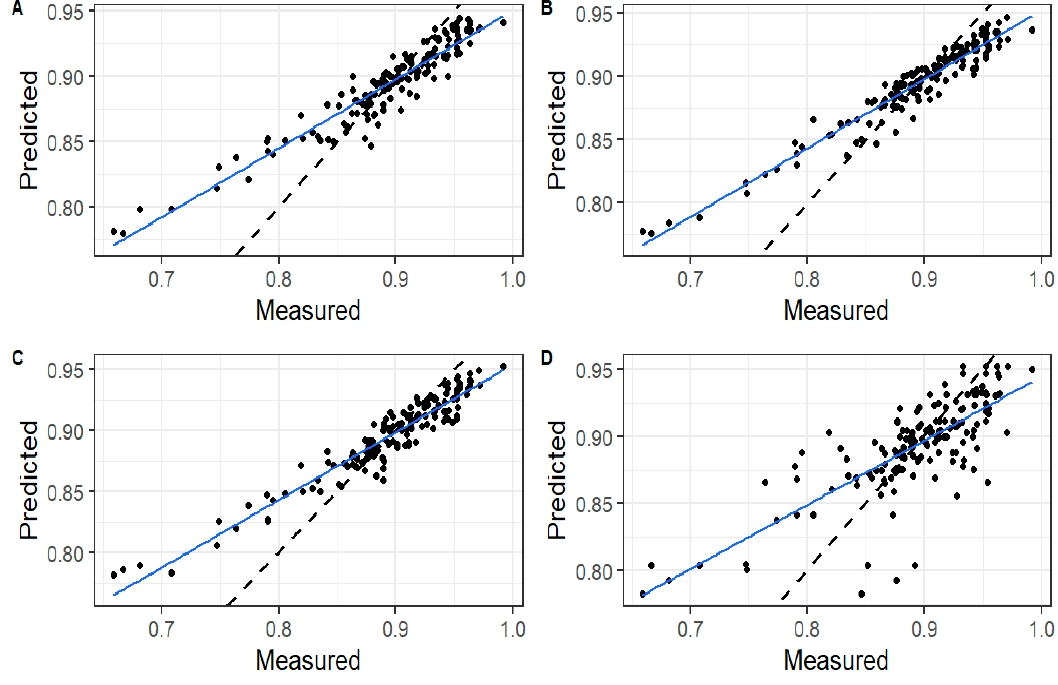
Figure 2. Scatter plot for the Shannon Index prediction. ( A ) is for Sentinel 2, ( B ) is for RapidEye, ( C ) is for PlanetScope, and ( D ) is for Landsat 8. The blue line is the line of best fit and the dashed line is the 1:1 line as shown on the individual plots.